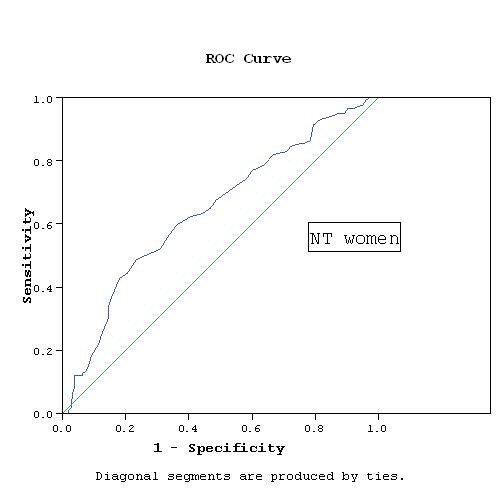
WC cutoff point by ROC curve in NT women. AUC = 0.697, p < 0.001 CI: 0.619- 0.776.